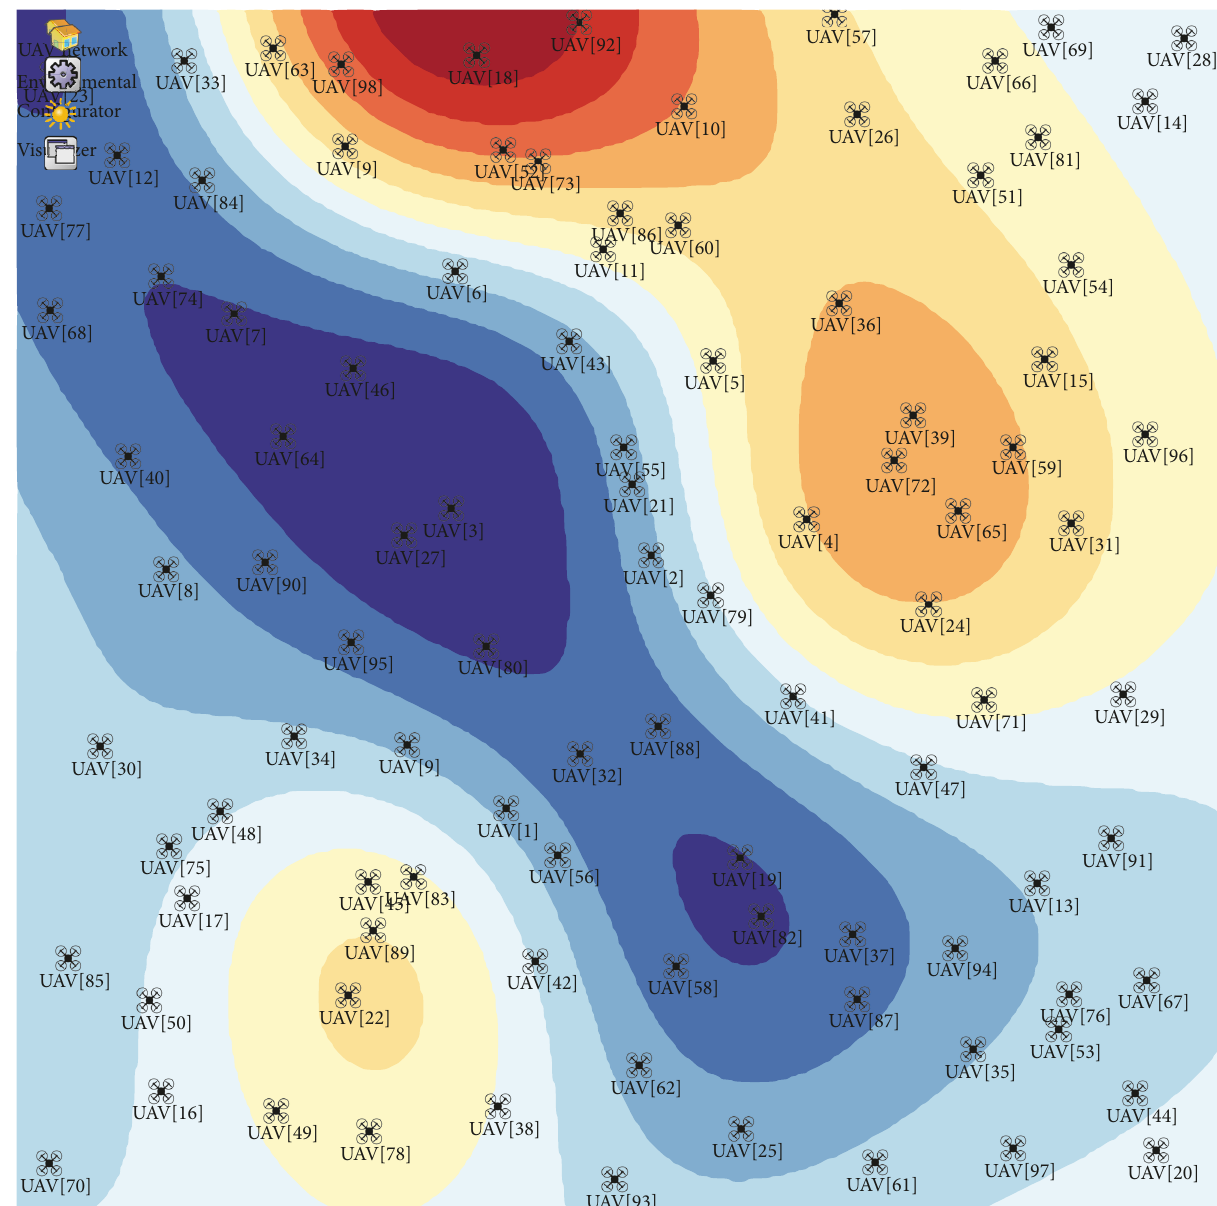
Figure 8: Example simulation scenario showing possible initial UAV positions over a randomly generated pollution map.